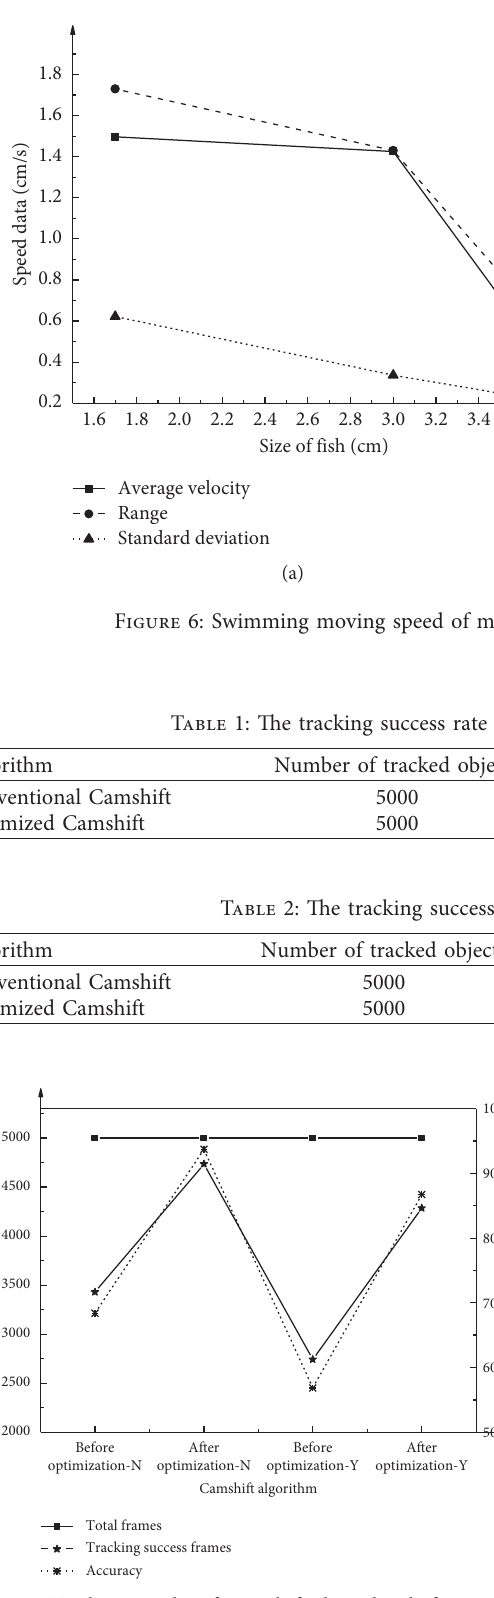
Figure 7: Tracking results of Camshift algorithm before and after optimization (in the figure, -N means without occultation, while -Y means with severe